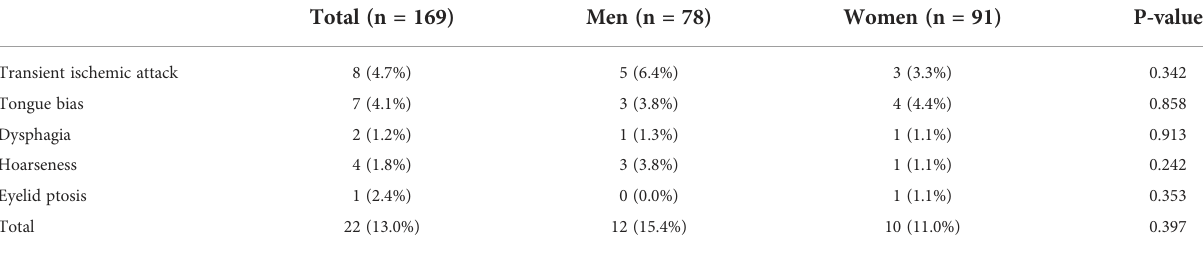
TABLE 4 The incidence of temporary postoperative